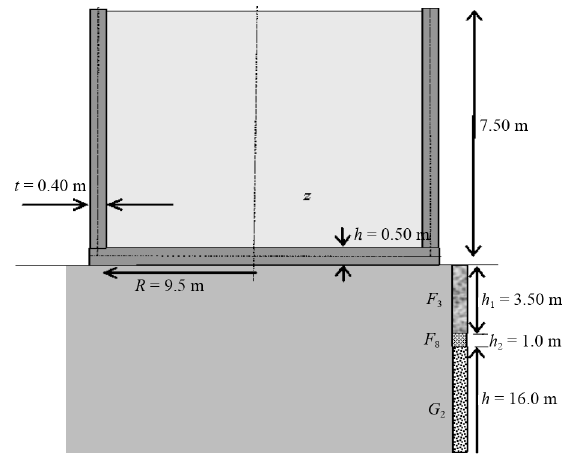
Fig. 3. The rotationally symmetric tank Model